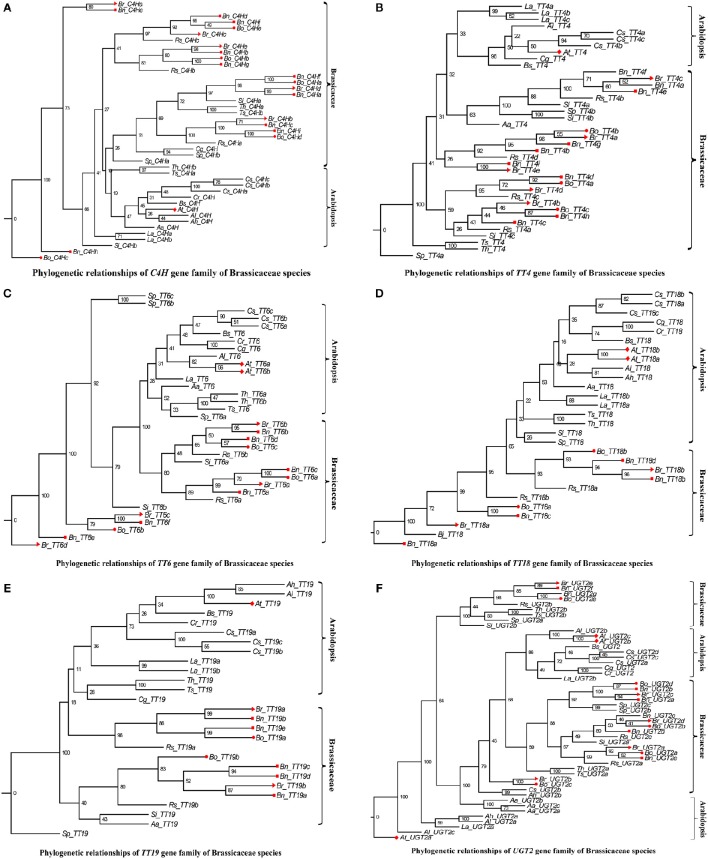
Phylogenetic relationships of C4H, TT4, TT6, TT18, TT19, and UGT2gene family of Brassicaceae species. The Red color diamond, triangle, circle, and rectangle were denoted the gene copies in A. thaliana, B. rapa, B. oleracea, and B. napus, respectively. Scale bar (the numbers) indicates the estimated number of amino acid substitutions per site. (A–F) were indicated C4H, TT4, TT6, TT18, TT19, and UGT2 gene family, respectively.